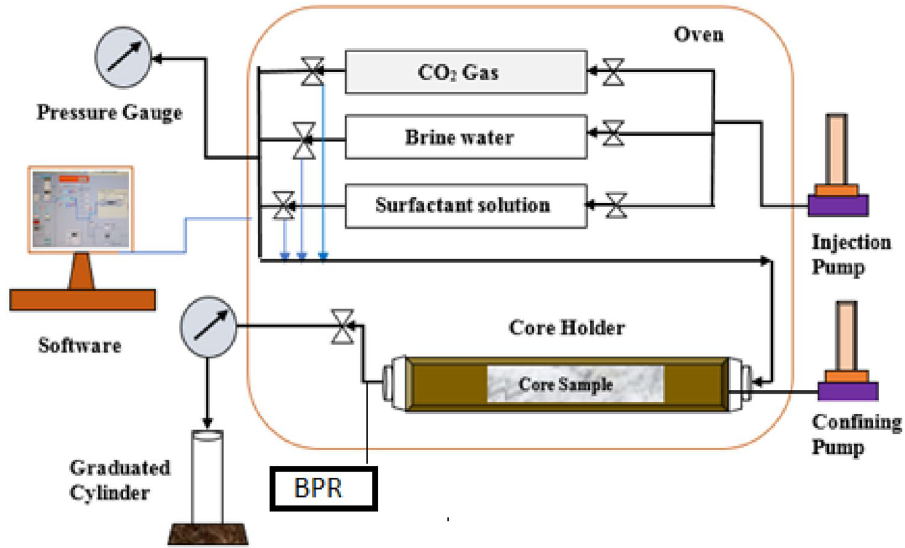
Fig. 2 Schematic diagram of